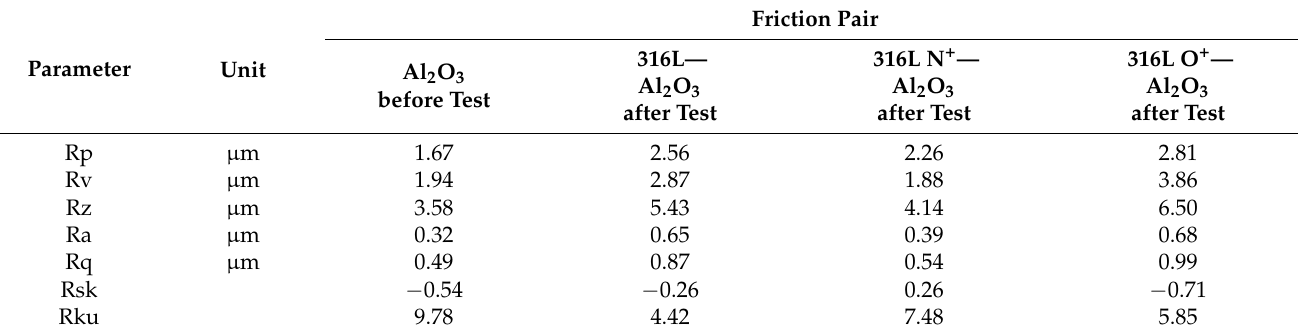
Table 7. Average parameters of the ball surface geometric structure after tribological tests with